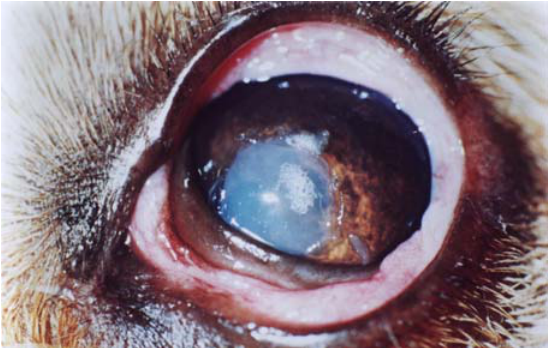
Figure 1. Detail of the keratectomized area immediately after application of the fibrin adhesive derived from snake venom in an animal of Group 1. There is a fibrin clot covering the